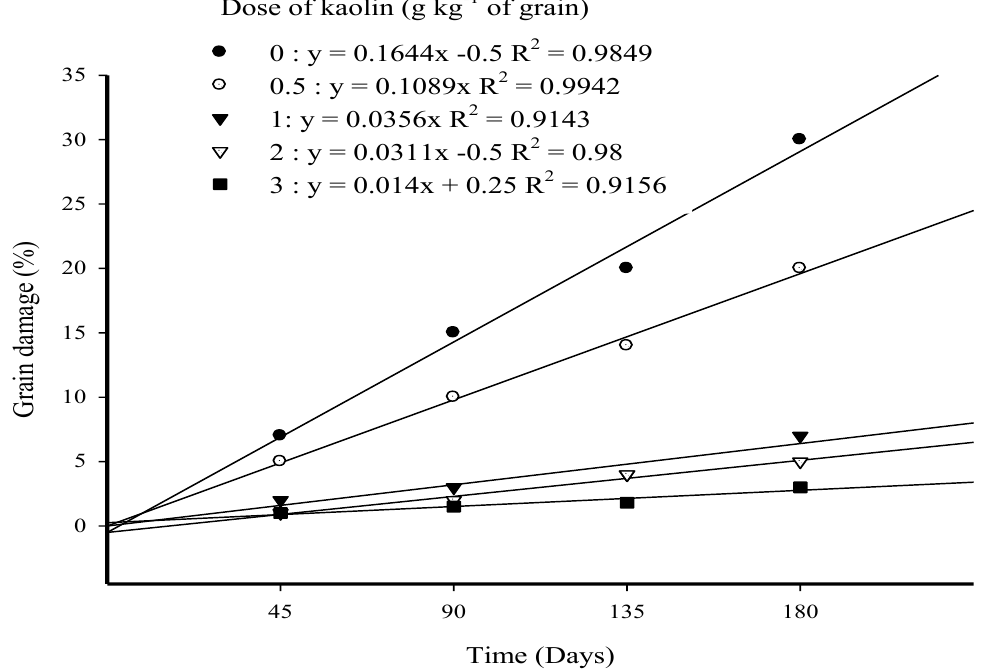
Figure 4. Grain damage over 180 days after Ephestia cautella larvae infestation on rice grains, following of kaolin.